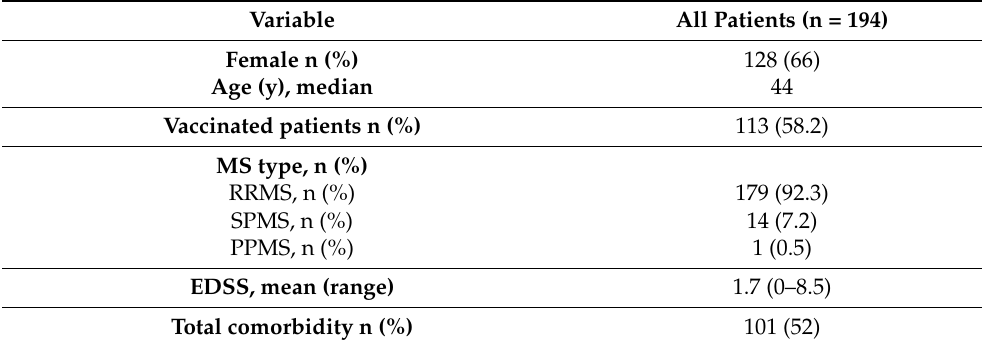
Table 1. Total patient characteristics concerning flu vaccination